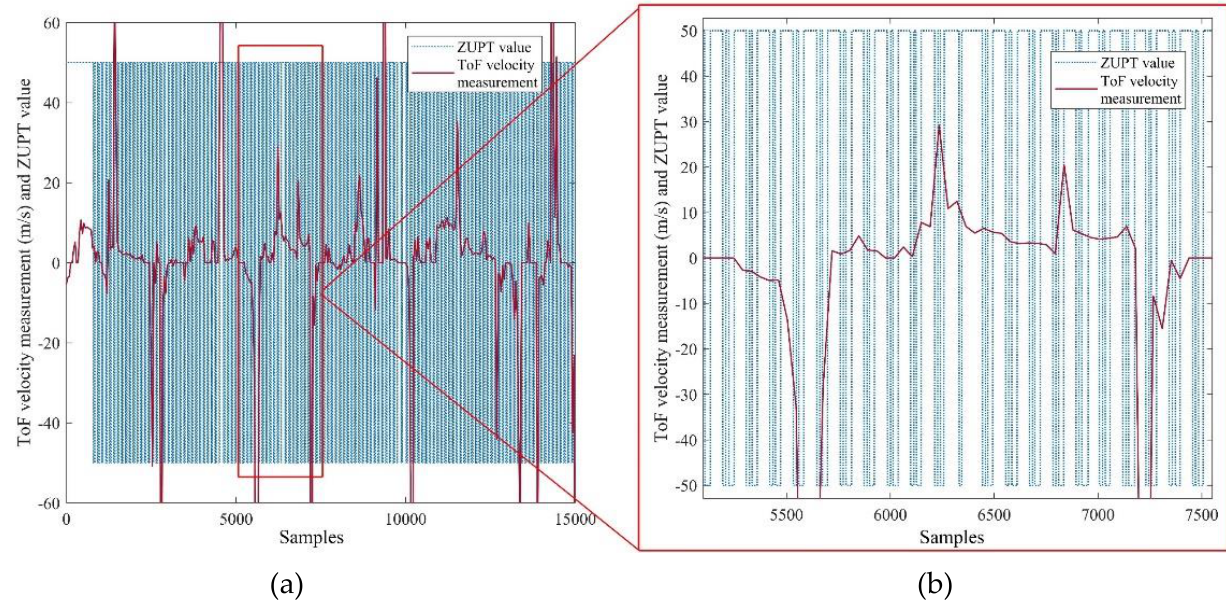
Figure 6. ( a ): Output of the stance and still detection phase and ToF velocity measurement for 150 s normal walking, ( b ): Magnified representation of the figure in 2.5 s.